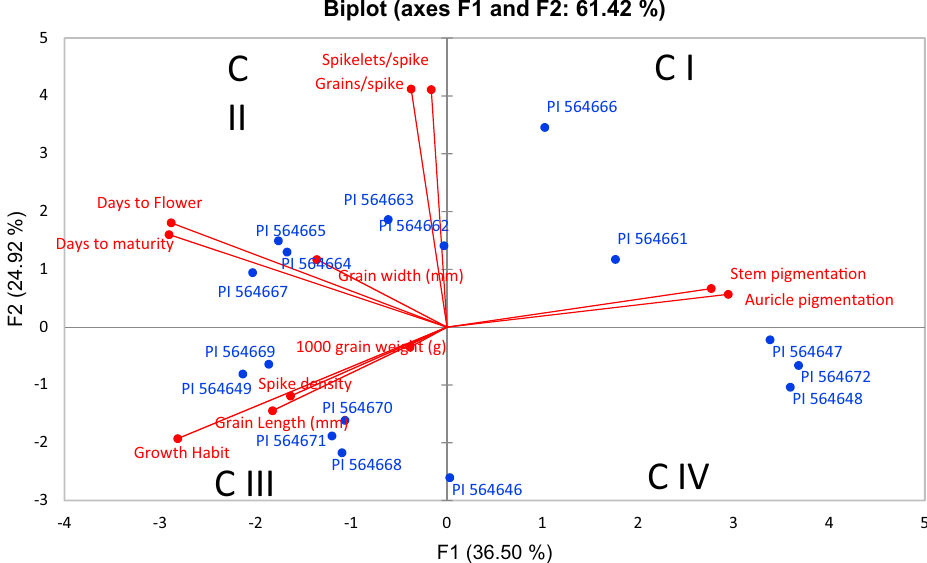
Figure 3: Biplot graph of PC 1 ( Factor 1 ) and PC 2 ( Factor 2 ) showing distribution of 16 Hordeum vulgare accessions into its four quadrants as clusters ( I – IV ) along with eigenvectors of the characters that most in fl uence on corresponding